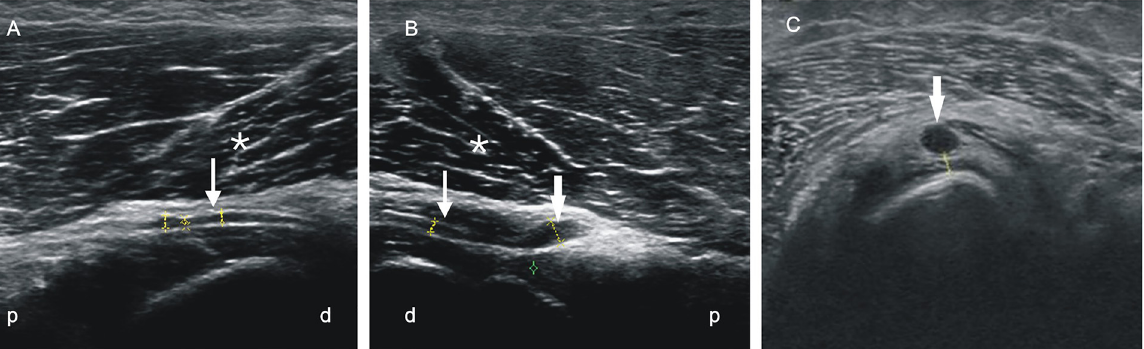
Fig 3. Sonographic studies of the patient with a posterior interosseous nerve (PIN) syndrome. (A, B) Longitudinal study of healthy PIN (A) and the affected side (B) with significant swelling (thick arrow) before entering the supinator muscle (asterisk). (C) Transversal study with a significant swelling of the PIN (arrow) anterior to the supinator muscle. p — proximal, d —